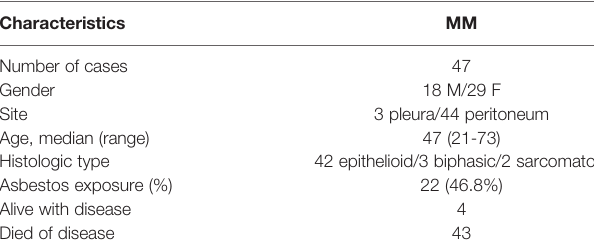
TABLE 5 | Patient and tumor Characteristics of MM cases.